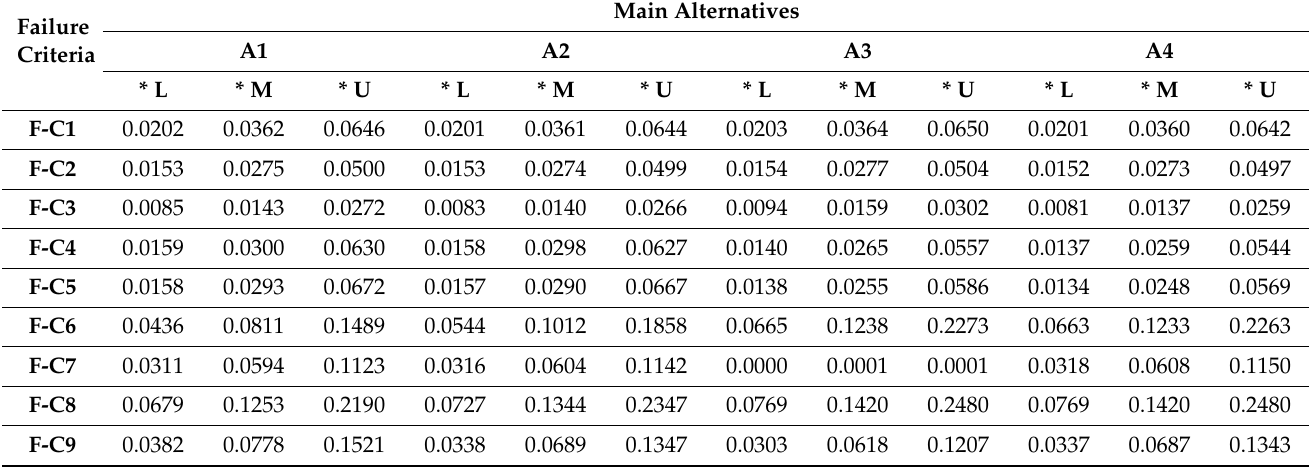
Table 11. The specific normalised decision matrix table with fuzzy elements for all the main alterna- tives under 70% of cyclic loading conditions.